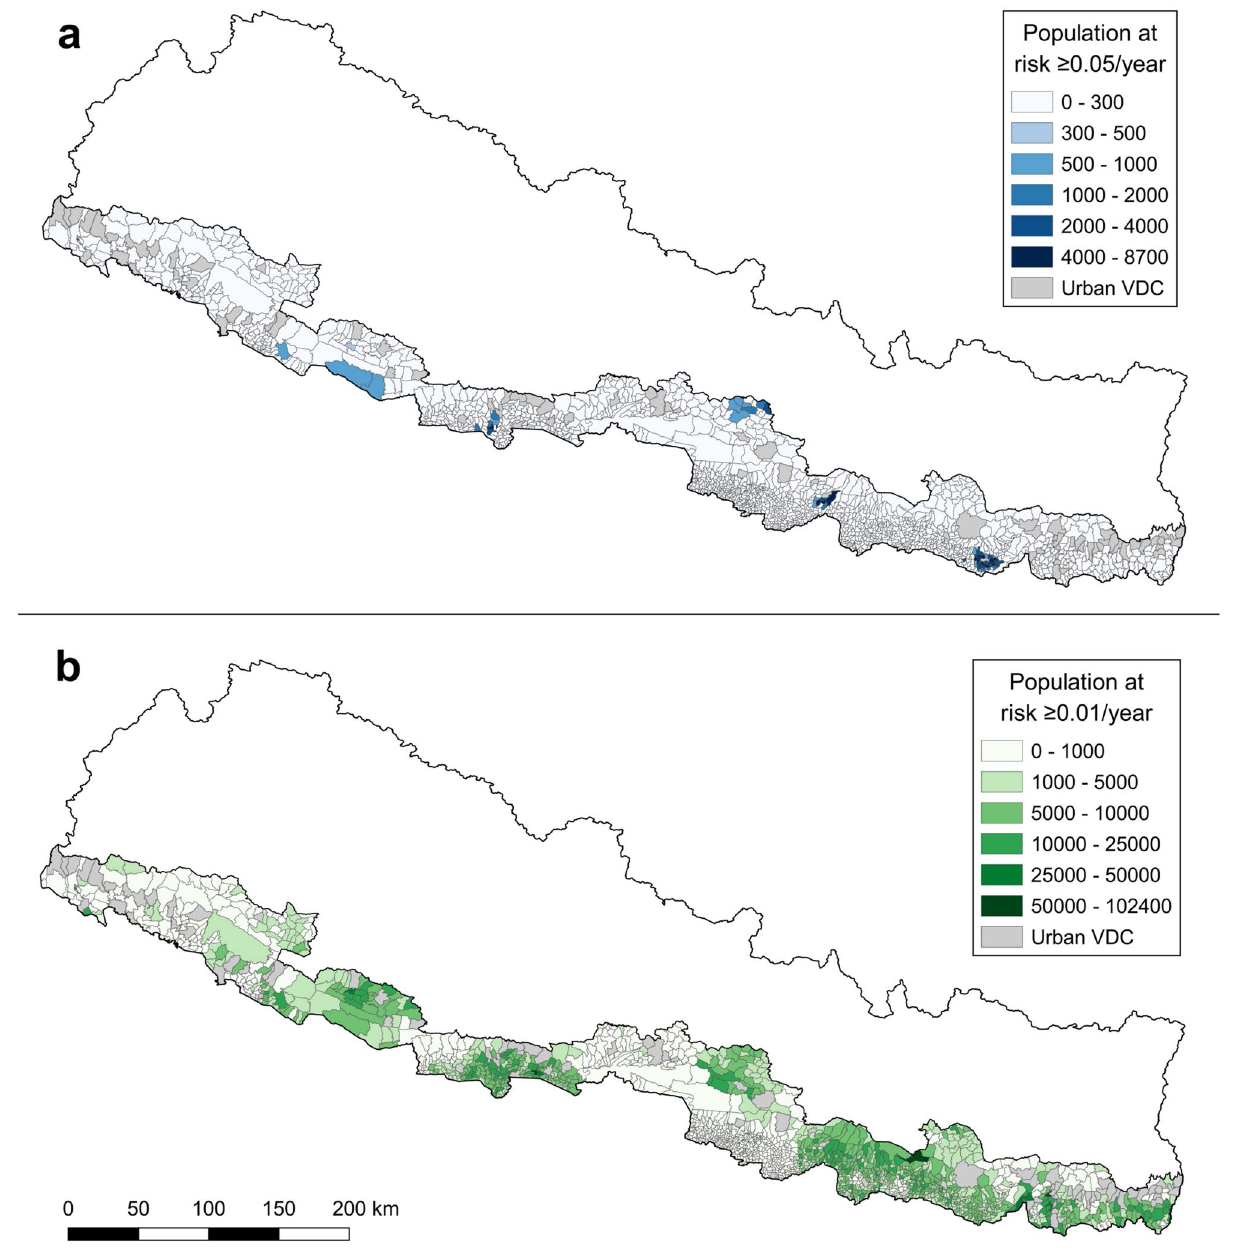
Figure 2. Choropleth maps aggregating the estimated population (WorldPop UN-adjusted for 2018) exposed at snakebite risks ≥ 0.05 ( a ) and ( b ) ≥ 0.01 per Village Development Committee during 12 months. (Source: vector map and administrative divisions from https:// gadm. org/ downl oad_ count ry_ v3. html, projected in the local WGS 84/UTM zone 45 N coordinate reference system in QGIS 3.18.3 (https:// qgis. org/ en/ final models without spatial random components and the worsening of the models’ goodness of fit as a result highlighted how snakebite risk and its determining factors are indeed spatially structured. A strong association between high snakebite incidence and mortality, and poverty was established from the analysis of 138 countries affected by the disease 32 . In this study, we identified the PPI , an indicator for poverty, as a highly influential risk-increasing factor for humans. This not only confirms the critical role of poverty as a driver for this Neglected Tropical Disease, but also offers the possibility to use a standardized index at individual household scale for similar studies. Chaves et al . 33 used the Poverty Gap, which is a simpler index expressing how far a person is from the average national poverty line, but to our knowledge, no study has used PPI for snake- bite in any way. Applying PPI as a snakebite risk predictor also addresses previous expert calls for an Ecohealth approach to consider the relationship between the structural characteristics of houses, poverty, and snakebite 34 . Three of the survey covariates had significant effects on the odds of snakebite. Food storage and straw stor- age increased them, while sleeping on the floor reduce them. The effect of the first two covariates is likely to be